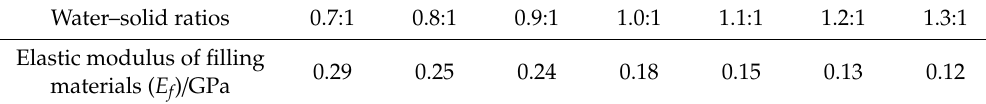
Table 2. Geological and mining parameters to calculate roof sinking amount in CECB [27,30]. Mining Height ( h ) /